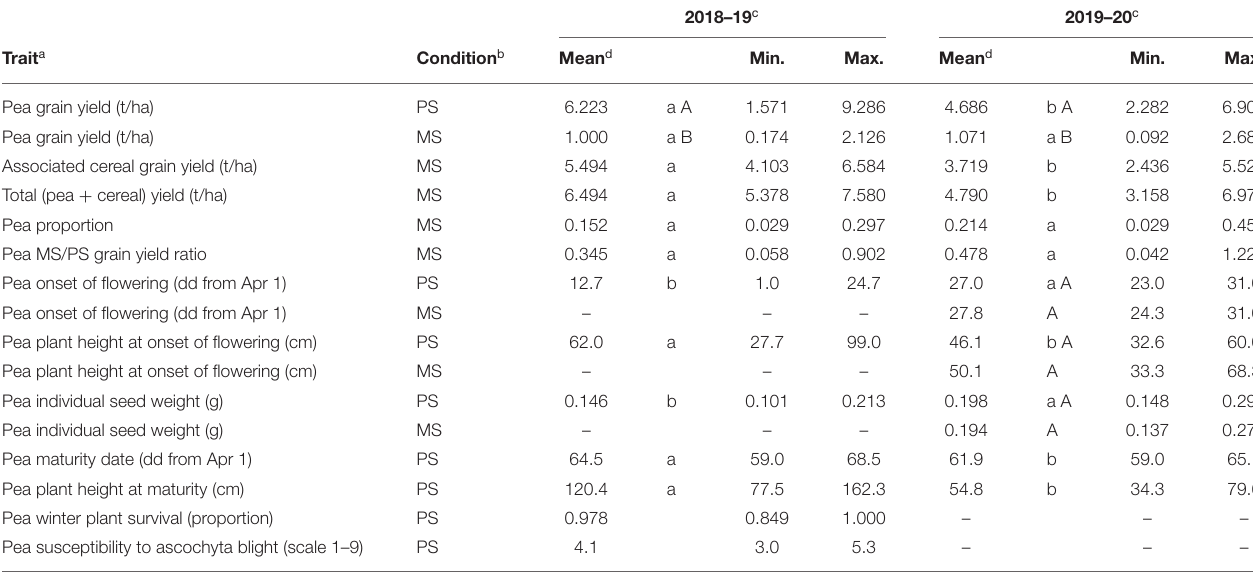
TABLE 1 | Mean and range values of pea traits in pure stand (PS) and pea and associated cereal traits in mixed stand (MS) for 144 pea inbred lines grown in two cropping